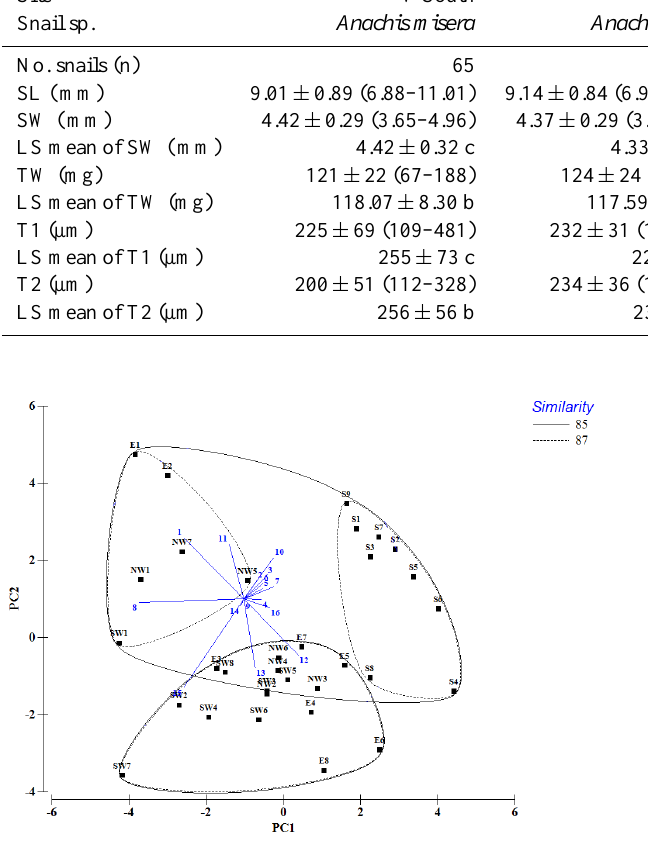
Figure 4. Results from the combined principal component anal- ysis (PCA) and cluster analysis of Bray–Curtis similarity (BCS) indices using standardized overall protein expressions of Anachis snails from different sampling sites. E: east; S: south; SW: south- west; NW: northwest; 1–16: variable of protein bands.